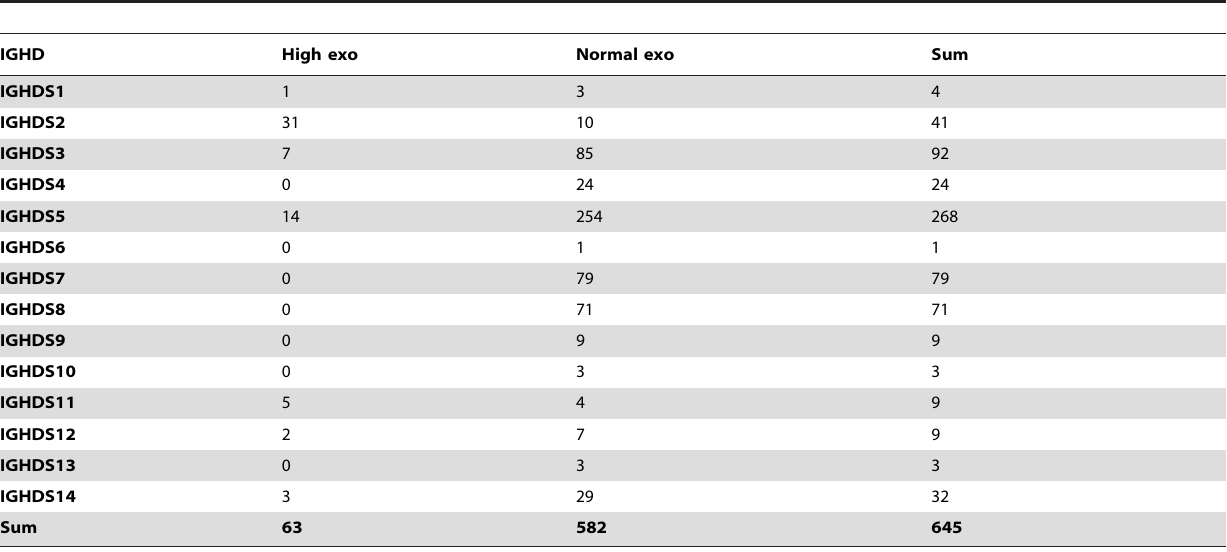
Table 6. The effect of removal of 63 cDNAs linked to high exonuclease activity to the frequency of IGHD segments in bovine fetal immunoglobulin